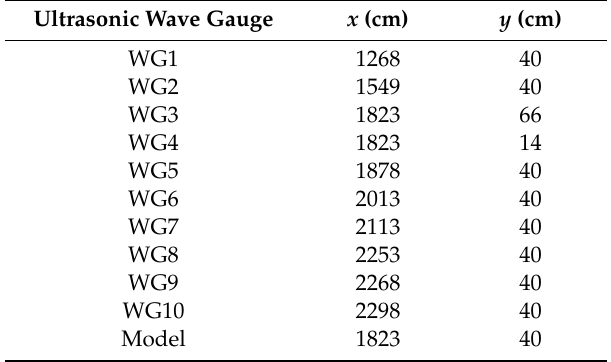
Figure 5. Wave gauges used in the experimental setup, ( a ) ultrasonic wave gauges (WGs) installed along the wave flume, ( b ) resistive type wave gauges (RWGs) installed inside the OWC WEC chamber (wires are highlighted in red). Photo is taken from the bottom of the OWC WEC chamber looking upwards in the direction of the OWC WEC orifice. Table 2. Distances of the ultrasonic WGs from the wave paddle and position of the scale model (OWC WEC/BOX).